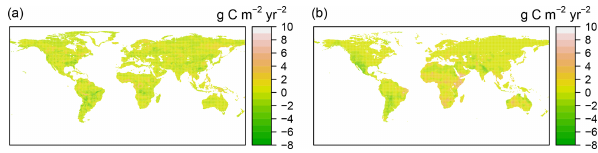
Figure 5. Spatial patterns of the temporal trend for RF-RA and Hashimoto2015-RA during 1980–2012.